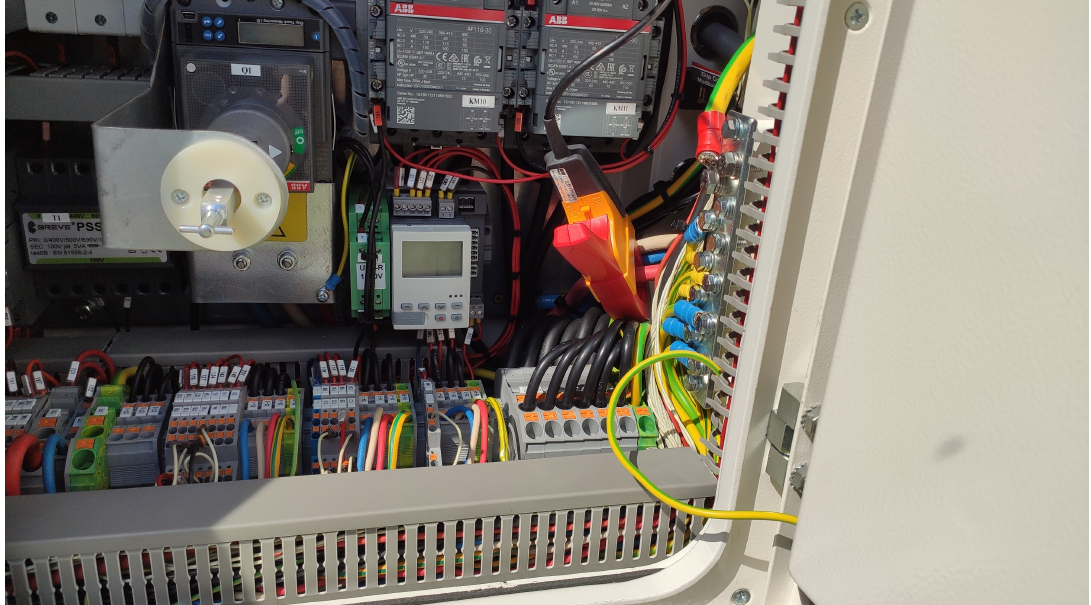
Figure 4. Current measurement clamps mounted on the wire of